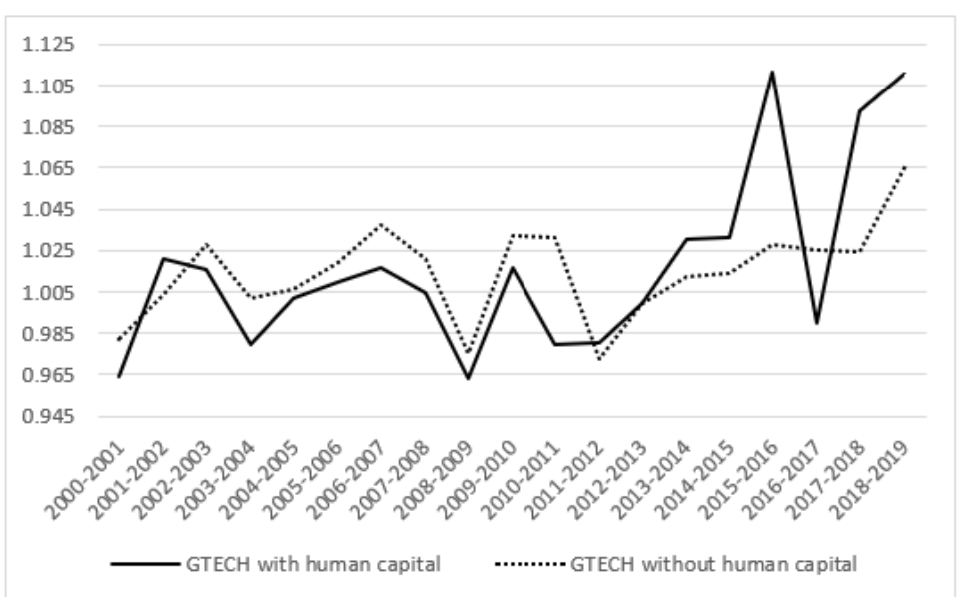
Figure 5. Comparison of technological progress decomposition.